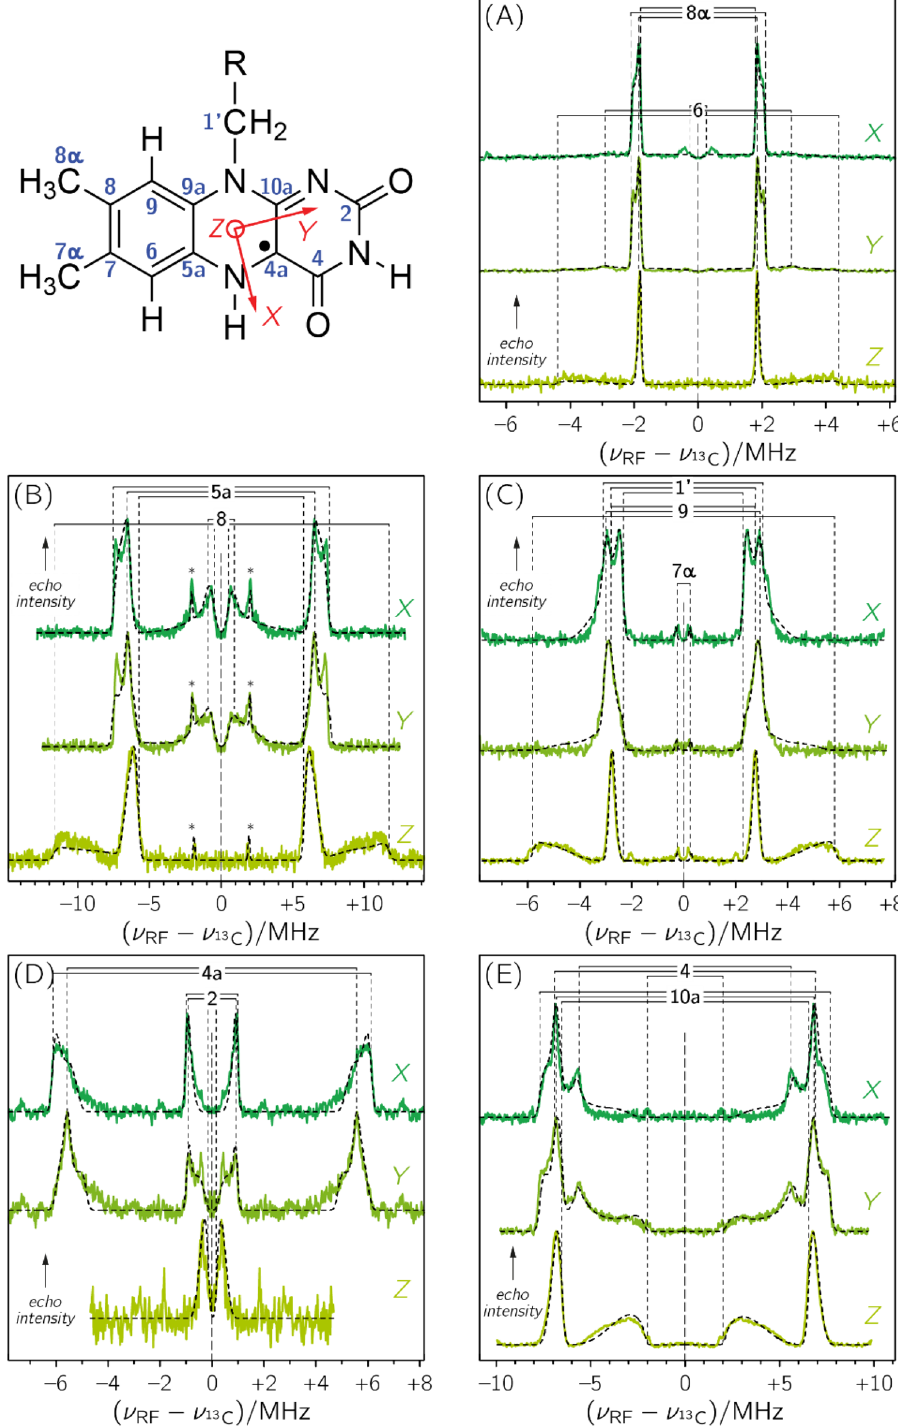
Figure 2. Frozen-solution Davies-type ENDOR spectra of specifically 13 C-labeled FAD cofactors in E. coli photolyase recorded with microwave frequencies around 94 GHz at 80 K: (A) [6,8α- 13 C 2 ]FAD, (B) [5a,8- 13 C 2 ] FAD (the asterisks denote resonances from the [7,9a- 13 C 2 ]FAD isotopomer, see also Fig. S2), (C) [1 ′ ,7α,9- 13 C 3 ] FAD, (D) [2,4a- 13 C 2 ]FAD, and (E) [4,10a- 13 C 2 ]FAD. Spectral simulations are depicted as black dashed lines. ENDOR spectra were collected at three magnetic field positions: at g X (dark green), g Y (medium green), and g Z (light green), see also Fig.